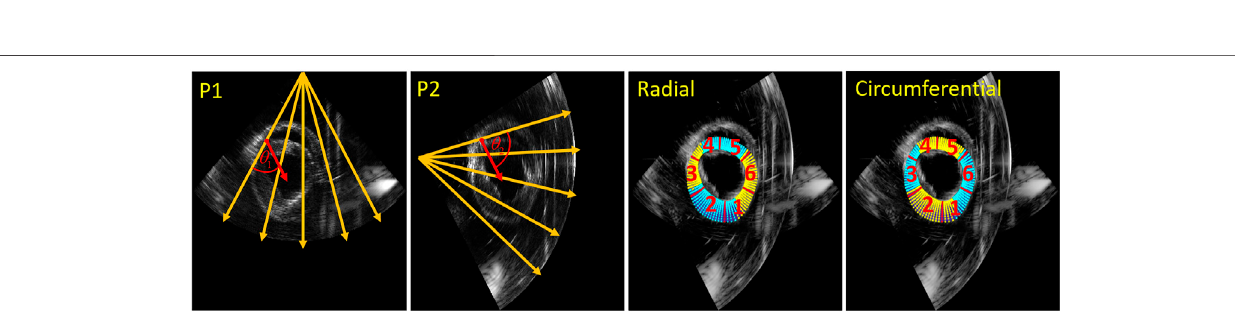
Frontiers in Physics |